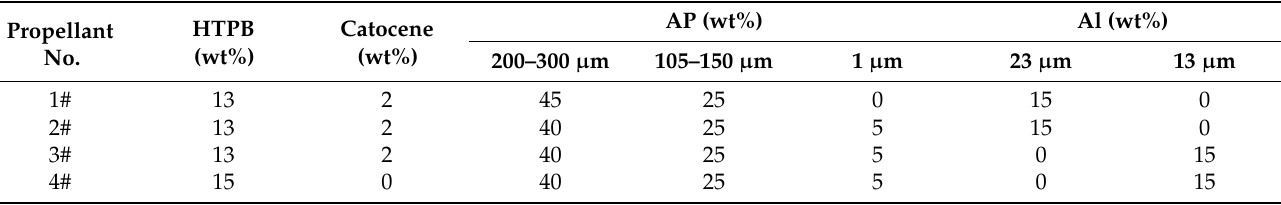
Table 1. Propellant formulations used.